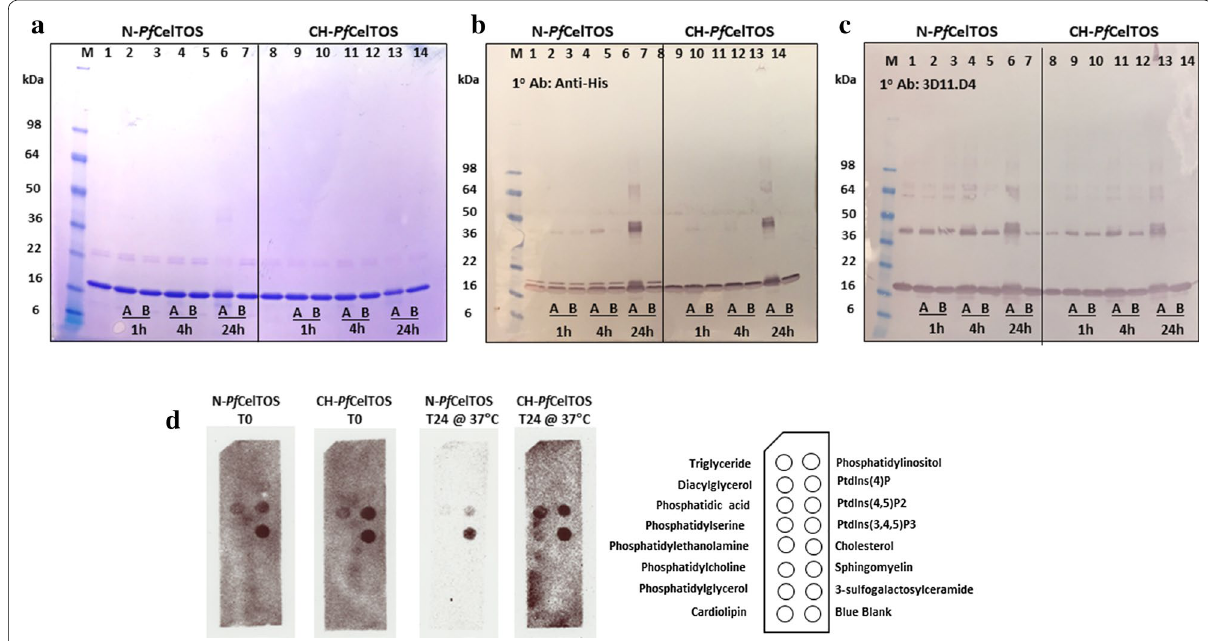
Fig. 1 Stability of N- Pf CelTOS and CH- Pf CelTOS incubated at 37 °C and 65 °C. a Coomassie blue total protein staining of N- and CH-proteins incubated at A: 37 °C and B: 65 °C for 1, 4 and up to 24 h. b Western blot analysis using anti-histidine mAb and c Western blot analysis using Pf CelTOS-C-term specific mAb 3D11.D4. Lane 1 for each gel or blot is the reference Pf CelTOS protein, untreated. d Lipid strip analysis of N- and CH- Pf CelTOS incubated at 37 °C for up to 24 h. T0 indicates control lipid strips for assessing changes in binding profile of both the